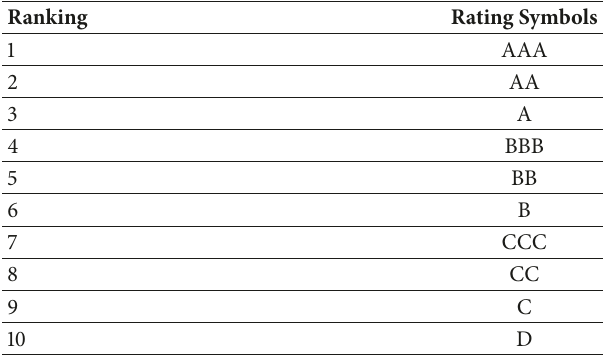
Table 3: List of credit rating